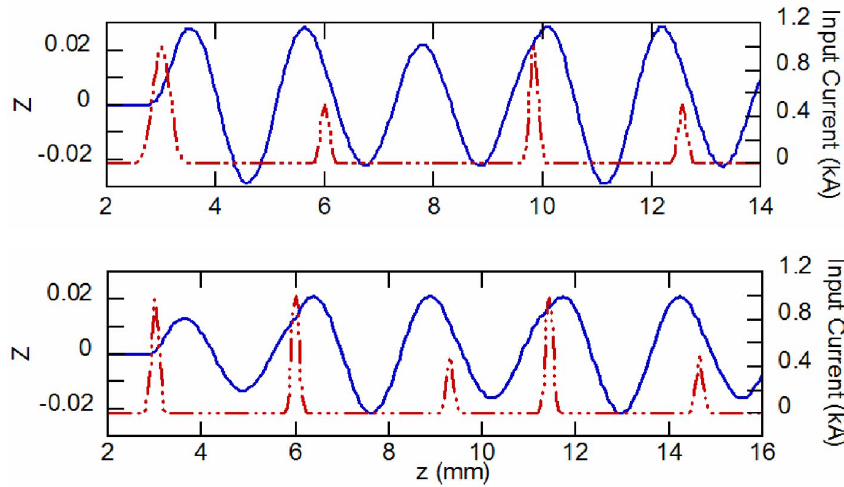
FIG. 6. (Color) Axial bunch current (dashed line) and transverse plasma wakefields for reduced bunch charge in alternate (load) bunches: (a) focusing forces for single initial drive bunch and (b) focusing forces for two initial drive bunches